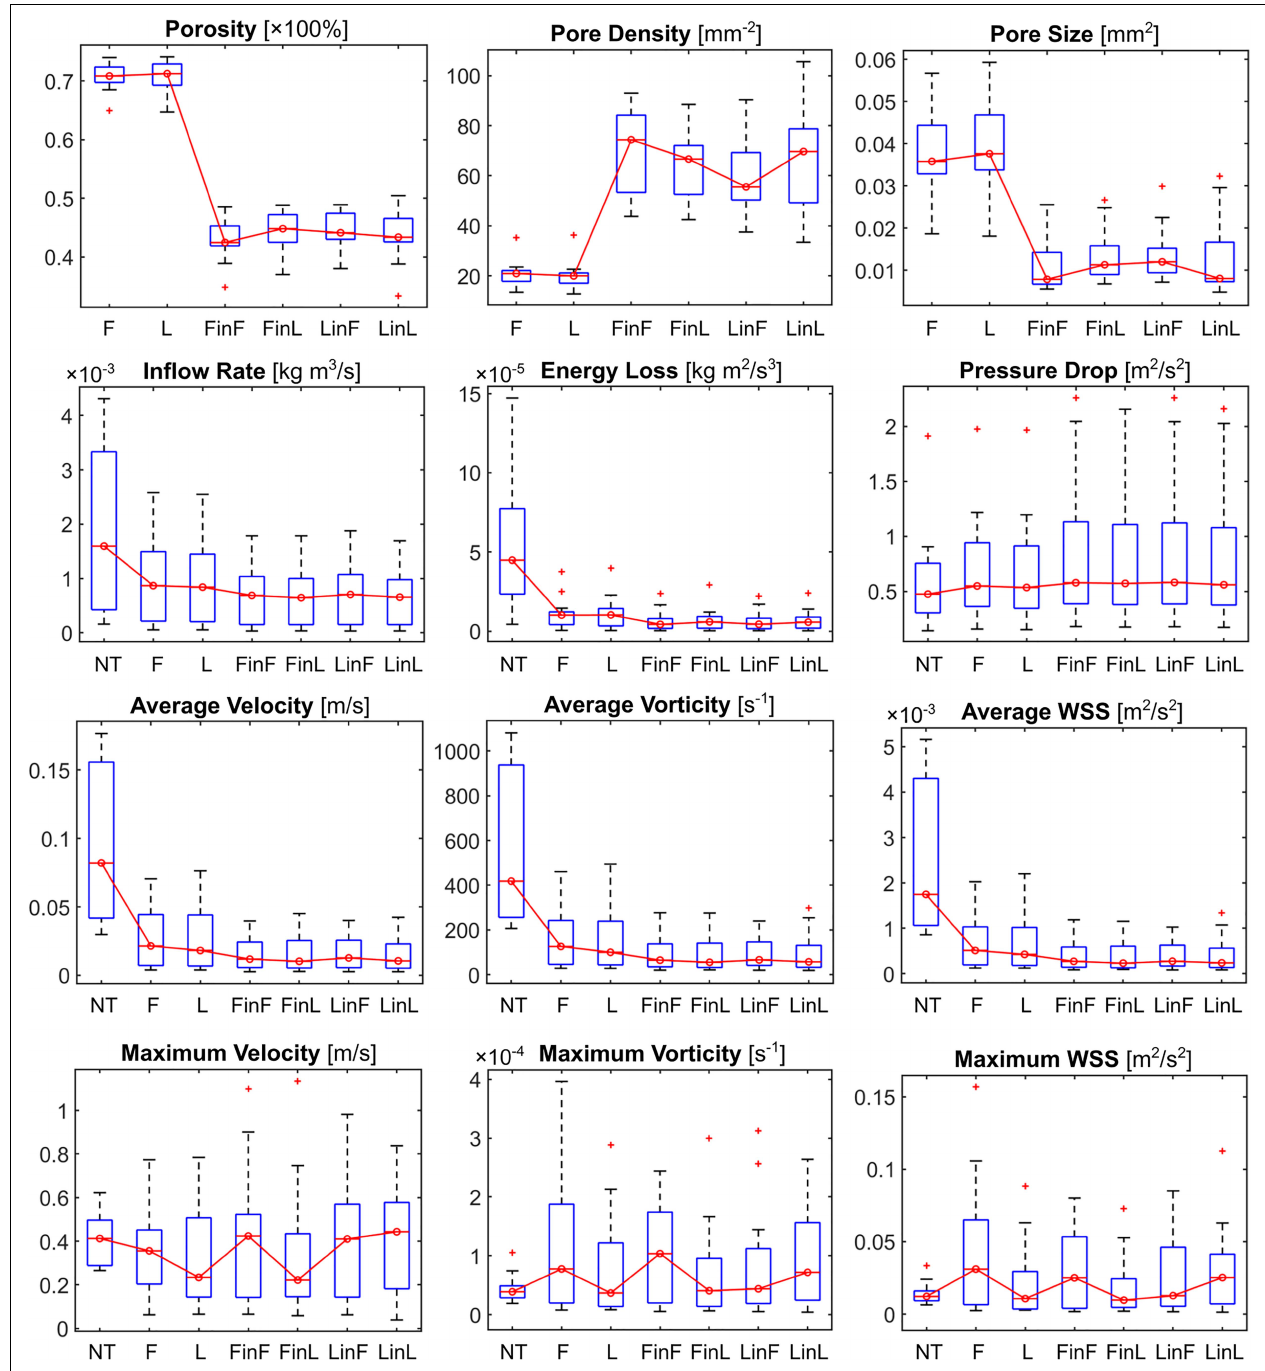
FIGURE 3 | Boxplots of the stent microstructural and IA haemodynamic parameters corresponding to different treatment scenarios. NT: untreated condition; F: treatment with a single stent of “fit” size; L: treatment with a single stent of “larger” size; and FinL: dual-stent treatment with the later-deployed stent being of “fit” size and the earlier-deployed stent being of “larger” size. The same naming convention applies to the remaining treatment scenarios: FinF, LinF, and LinL.